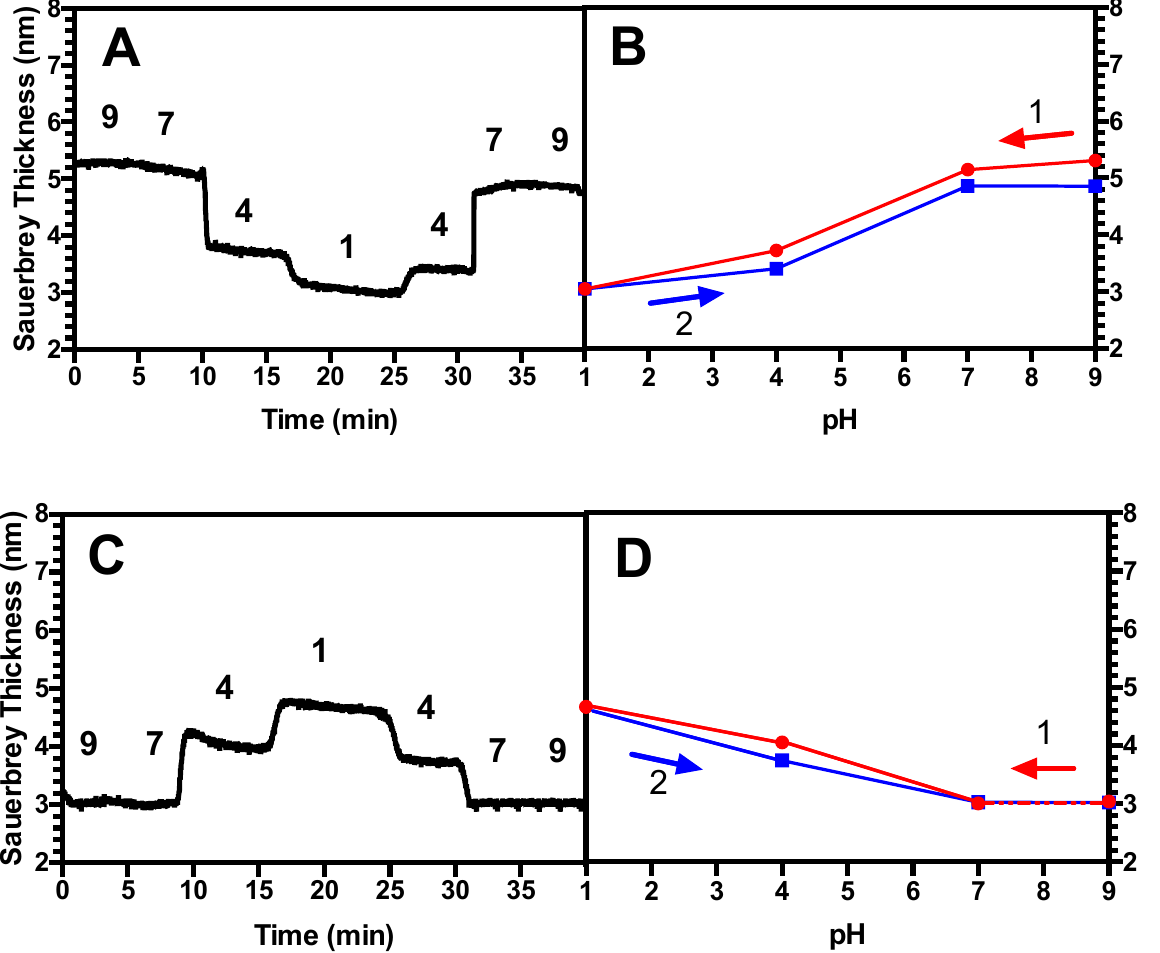
Figure 2. ( A ) Representative thickness responses to pH changes for a 2 kDa PAA brush with no polyethyleneimines (PEI) adsorbed, grafting density σ = 0.87 in 100 mM KCl with pH varied as shown, with effect of overlying solvent subtracted, as discussed at the end of the methods section. ( B ) Time-averaged thickness response vs. pH obtained from ( A ), with numbers indicating the order in which the pH scans occurred. Error bars in ( B ) and ( D ) represent the standard deviation for N = 3, but are invisible since they are smaller than the symbols. ( C ) Representative thickness response for a (PAA/PEI) bilayer with a 2 kDa PAA brush underlayer, grafting density σ = 0.87 in 100 mM KCl and 2.5 kDa PEI adsorbed overlayer, with solvent subtracted. ( D ) Time-averaged thickness response vs. pH obtained from ( C ). The dashed line represents a connecting segment that falls on top of another